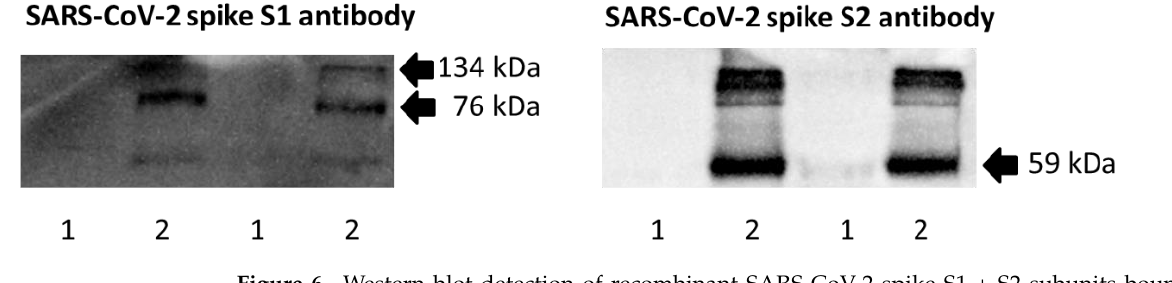
Figure 6. Western blot detection of recombinant SARS-CoV-2 spike S1 + S2 subunits bound to S. pneumoniae biofilm (using whole bacterial cell lysate). The blots were individually probed with spike S1 and S2 antibodies. The predicted molecular masses of recombinant spike S1, S2 ECD, and S1 + S2 proteins are 76, 59, and 134 kDa, respectively. Lane 1: Control of S. pneumoniae only; lane 2: S. pneu- moniae incubated with S1 + S2 subunits. The results of biological duplicate experiments are shown.